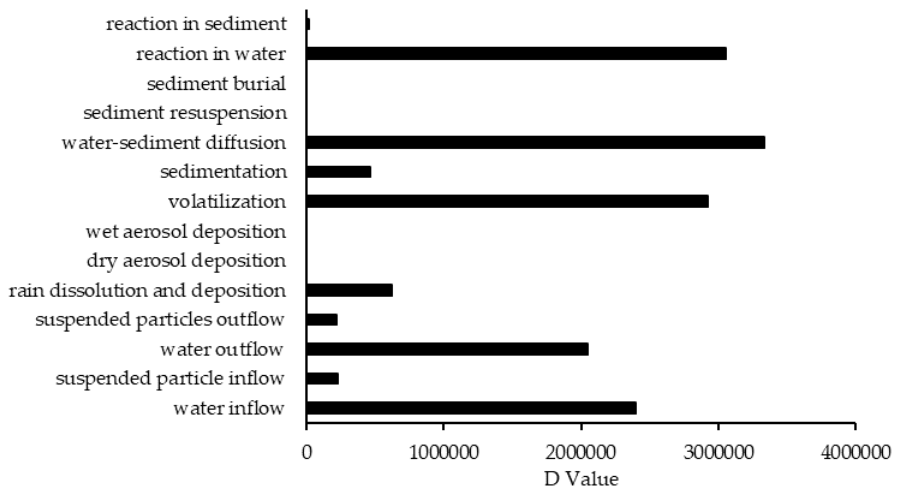
Figure 6. The D values of different processes that affect the fate of contaminants.